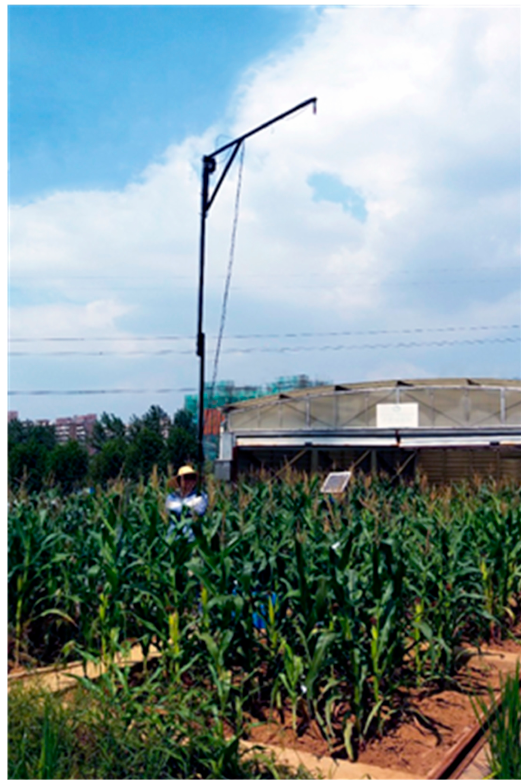
Figure A3. A hand-held mobile system for measuring canopy spectral reflectance. A 2 m horizontal boom is mounted on a 4 m vertical pole to support an Analytical Spectral Devices (ASD) FieldSpec 3 spectrometer to measure the canopy optical spectra in the nadir direction.